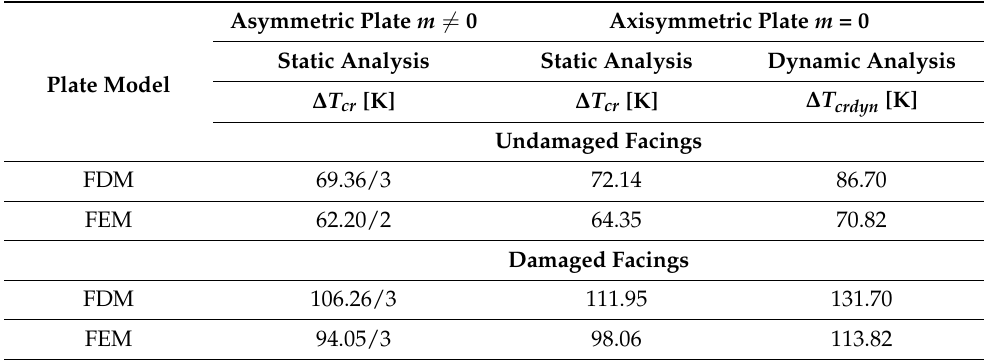
Table 4. Critical static and dynamic temperature differences of the FDM and FEM plate models loaded thermally with positive